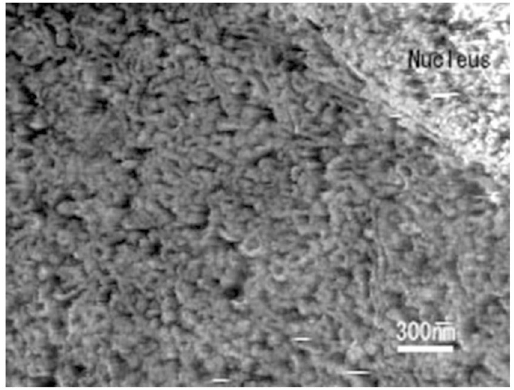
Figure 7. Atomic force imaging of the cryosections of a pigment epithelial cell in retina. The cytoplasm in the perinuclear region is occupied by a complicated network of membranous structures (likely smooth endoplasmic reticulum). A similar expanse of membranous structures has been not detected with thin-section or freeze- etching